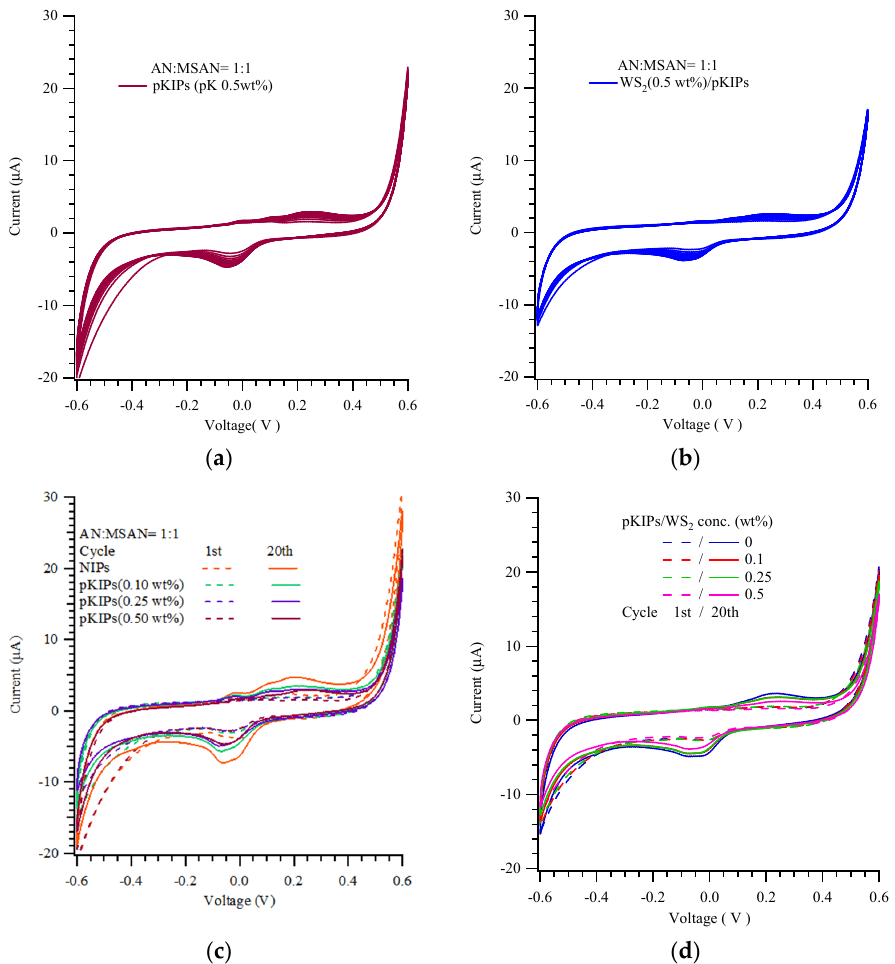
Figure 1. Cyclic voltammetry of peptide K-imprinted polymers (pKIPs), doped with ( a ) 0, ( b ) 0.50 wt% of 90 nm WS 2 during the electrochemical polymerization. Cyclic voltammetry of the 1st and 20th polymerization cycles during the preparation of peptide-imprinted polymer electrodes with various concentrations of ( c ) peptides K or ( d ) 90 nm WS 2